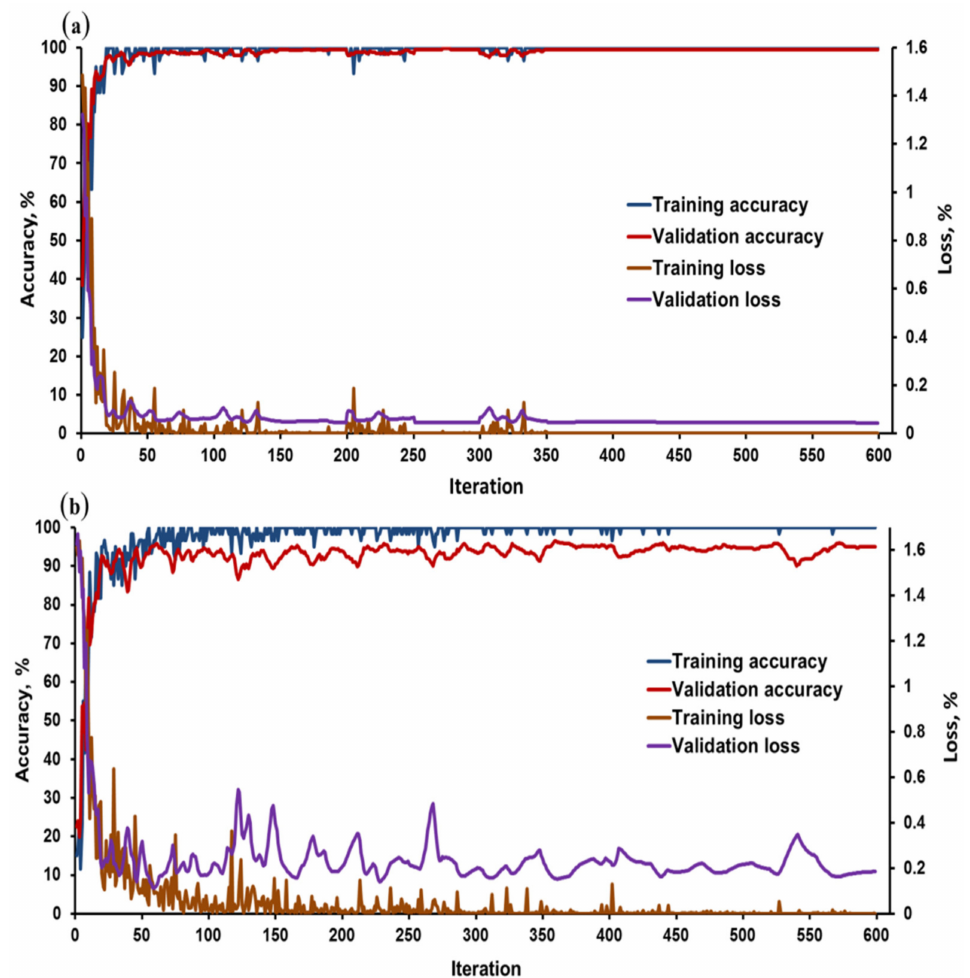
Figure 7. Training accuracy, validation accuracy, training loss, and validation loss for each epoch/iteration of the training process using Inceptionv3 ( a ) and ResNet18 ( b )